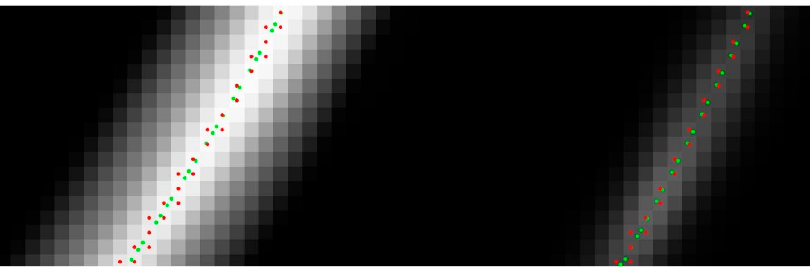
Figure 8. The location result of the center points of the interference ring in the experimental spectrum. (Red points are the candidate points, and green points are the final sub-pixel points.)